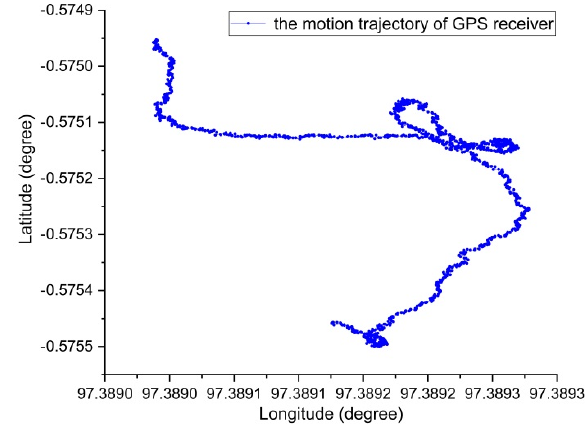
Figure 6. GPS trajectory on buoy.